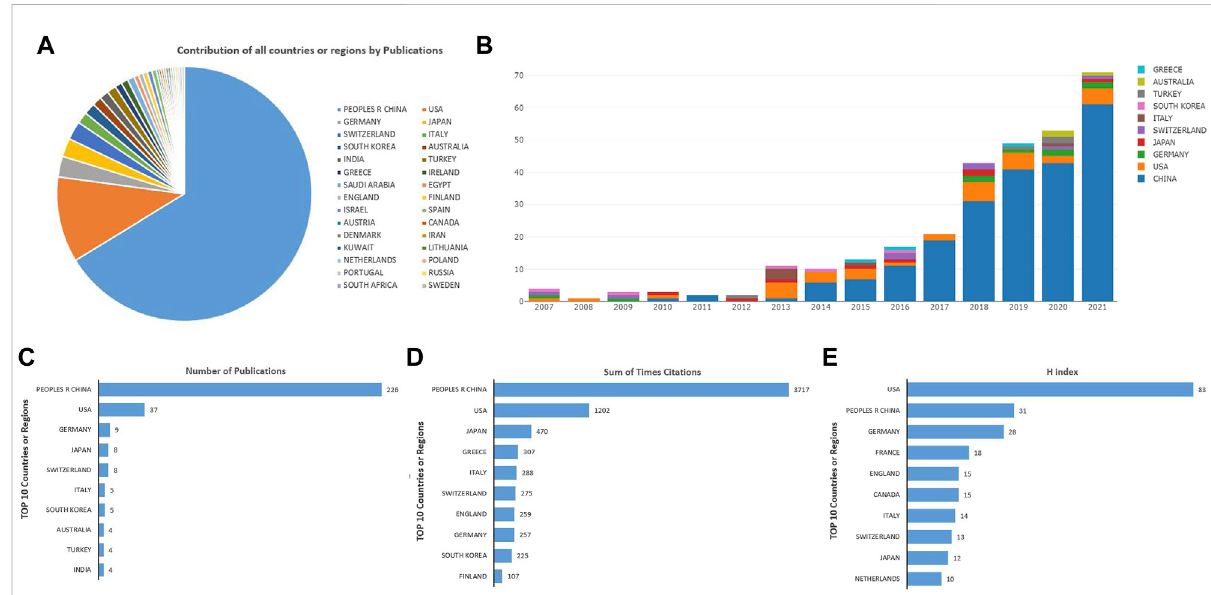
FIGURE 2 (A) Contribution of all countries by Publications. (B) The distribution of the bibliographic records per year of the top ten countries on oxidative stress in intervertebral disc degeneration. (C – E) Total number of publications, sum of total citations, and H-index of top ten countries on oxidative stress in intervertebral disc